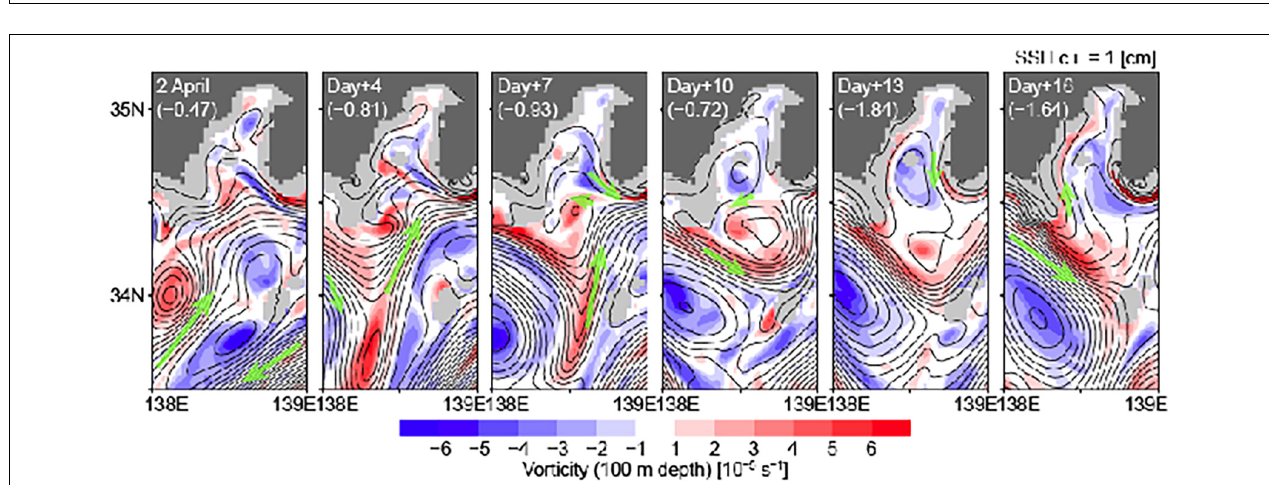
FIGURE 10 | Time series of changes in the potential temperature at 100 m depth in Suruga Bay during the negative (A) and positive (B) EOF1 events. x -axis denotes days from the EOF1 peak; y -axis denotes potential temperature changes from the value on the EOF1 peak day. Thin black lines indicate the individual events. Red line indicates the averaged time series. Green lines in (A,B) indicate the negative EOF1 event in April 2017 and the positive EOF1 event in June 2017, respectively.